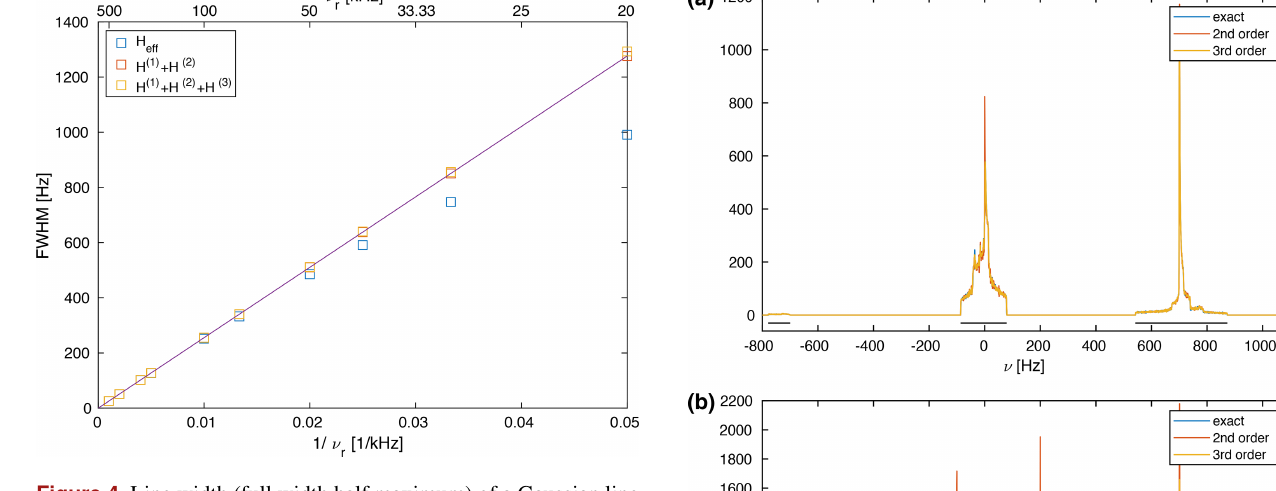
Figure 4. Line width (full width half maximum) of a Gaussian line with the same second moment as the powder line shape shown in √ 2ln(2) M 2 ). The line width obtained from Fig. S1 (FWMH = 2 second-order and third-order effective Hamiltonians correlates al- most perfectly linearly with ω − 1 r , while the line width obtained from the exact effective Hamiltonian shows some deviations which become more prominent below 50kHz. This deviation (narrower line width) is the contribution of the fourth-order term as discussed above (see Fig. 3).